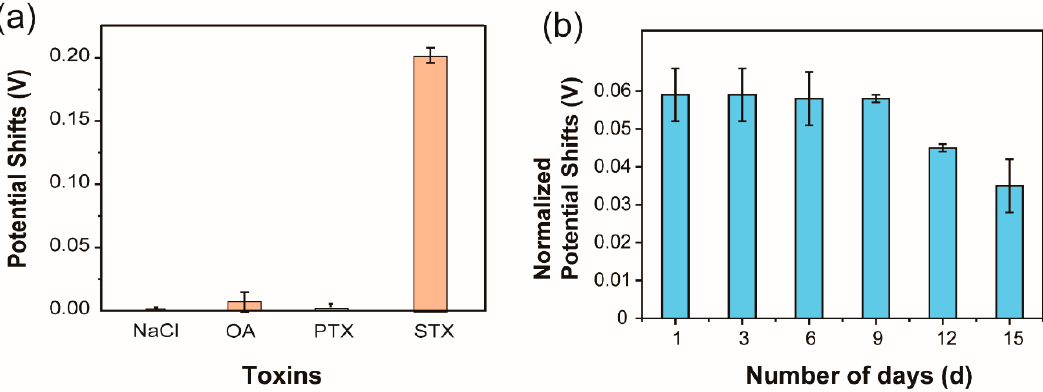
Figure 5. ( a ) Selectivity test of the aptamer sensor to 10 nM NaCl, 1 nM STX, 10 nM PTX, and 10 nM OA. ( b ) Stability test of the MXene-Aptamer sensor to 1 nM STX. All the experiments were repeated three times.